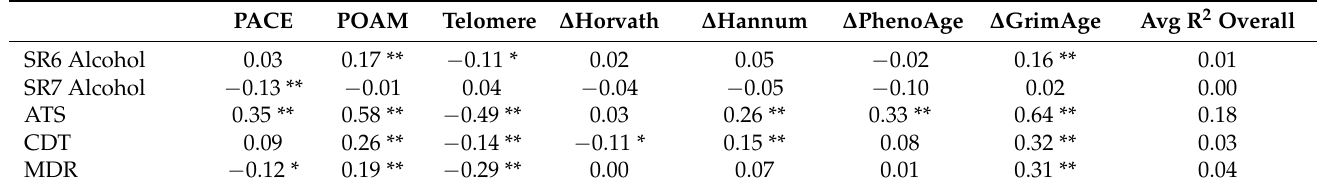
Table 5. Pearson correlation coefficients and average variance explained for each of five metrics of alcohol consumption with respect to each of the seven indices of EA.